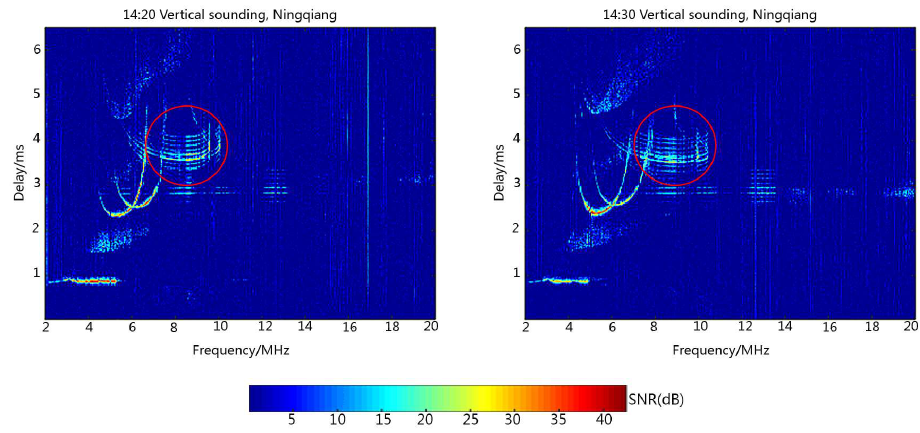
Figure 6. Multi-station sounding experiment using non-orthogonal complementary code.